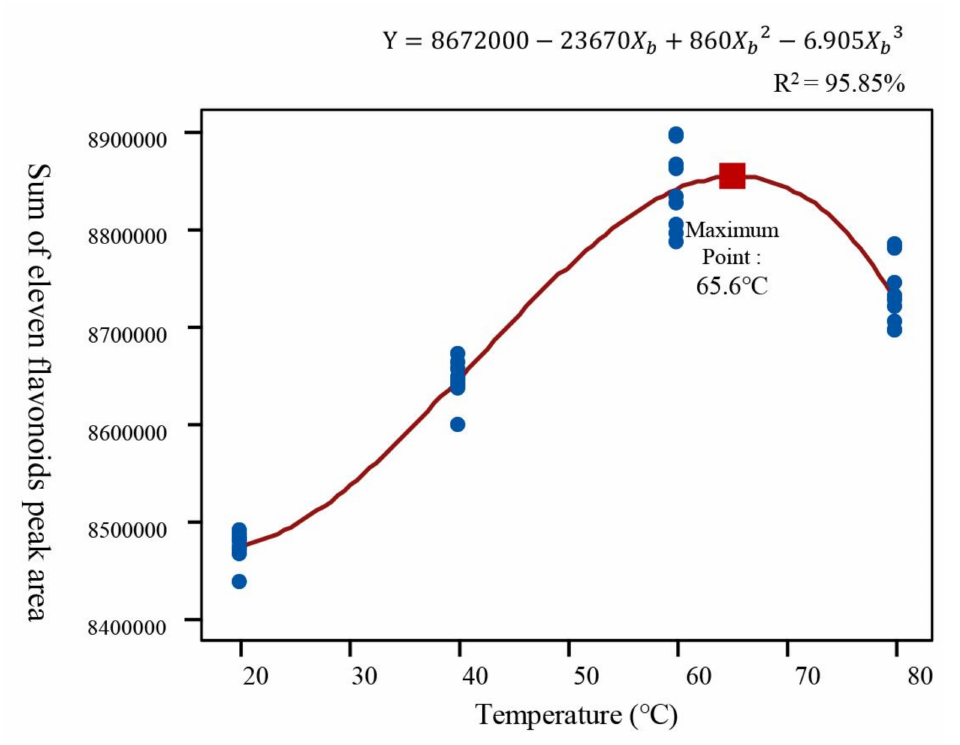
Figure 5. Polynomialregressioncurvebytemperature( ◦ C,X b